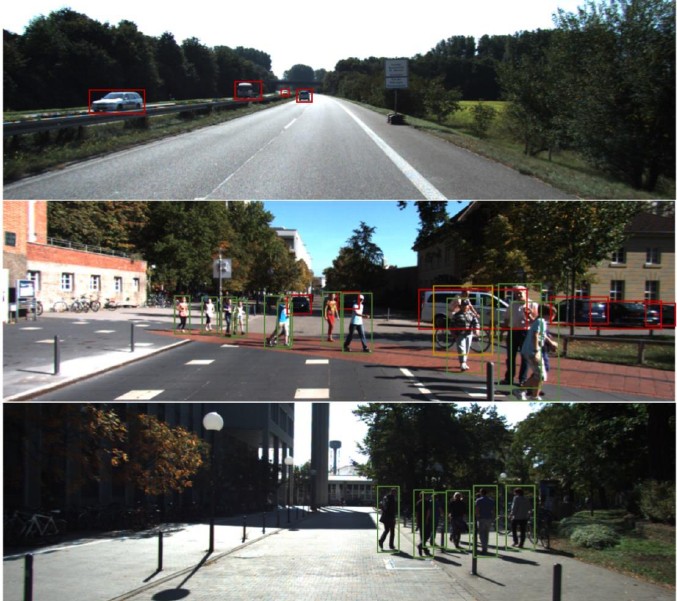
Figure 10. Detection results on the KITTI dataset. AspectNet accurately detected objects of different scales in traffic scenes, notably when multiple objects overlapped, as shown in the second result.